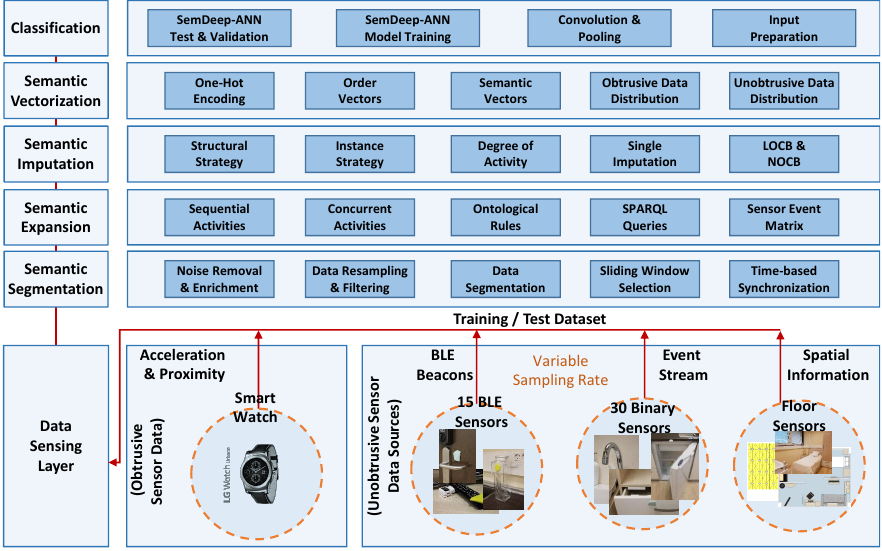
Figure 2. A detailed view of SemImput